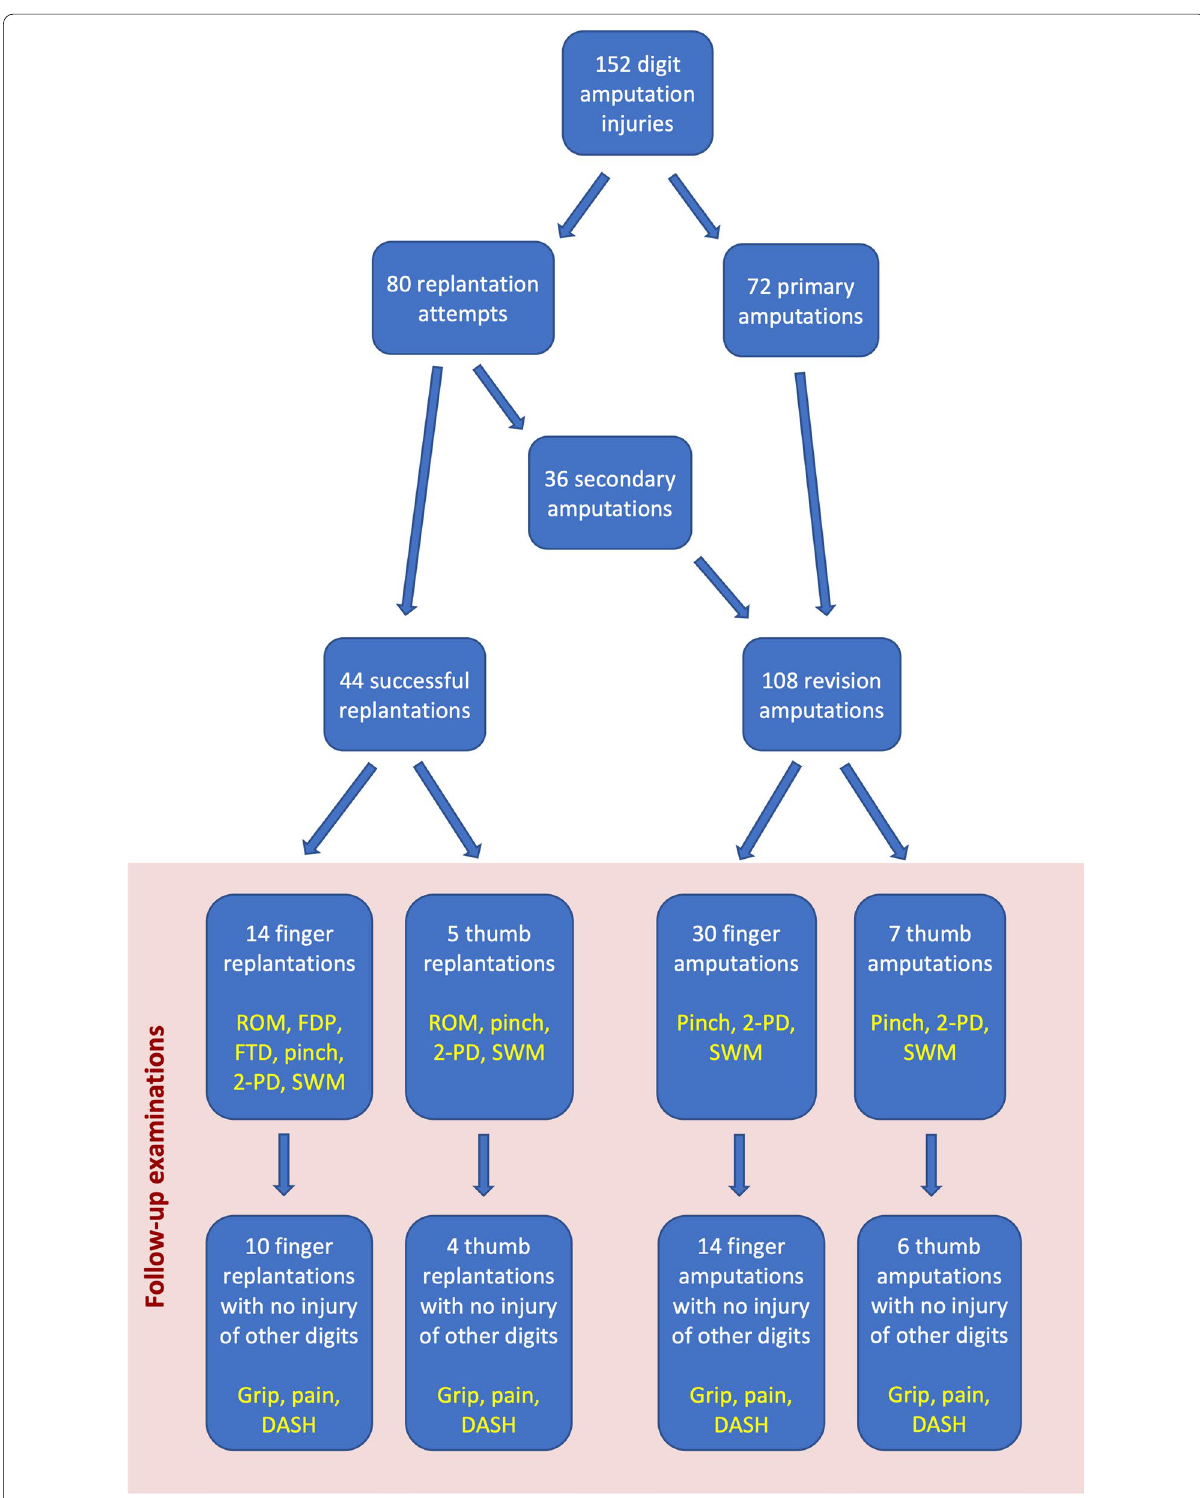
Fig. 1 Flowchart depicting the distributions of patients and digits according to the different assessments during follow-up examination. Tests concerning the function of the whole hand and not of a single digit, such as grip strength, pain levels, and DASH score, were performed in patients with a single-digit injury